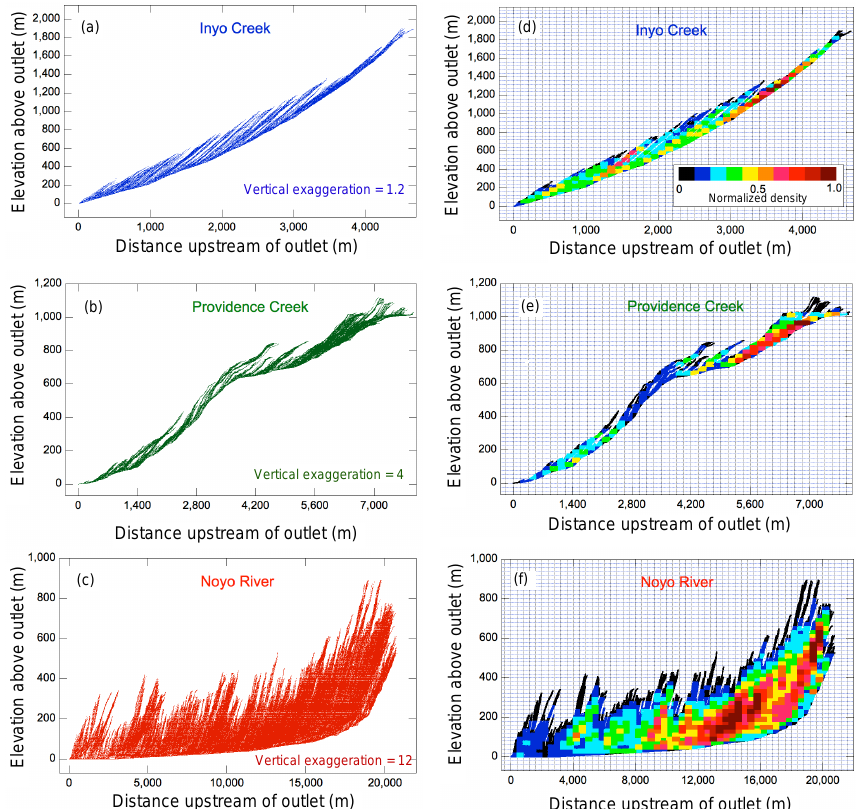
Figure 4. Joint distributions of elevation and travel distance. Distribution of source-area elevations and travel distances from 10m DEMs of catchments drained by (a) Inyo Creek, (b) Providence Creek, and (c) the Noyo River. Bivariate frequency distributions of elevation and travel distance for each catchment (d–f) show relative density (color bar in d ); data binning as in Fig.